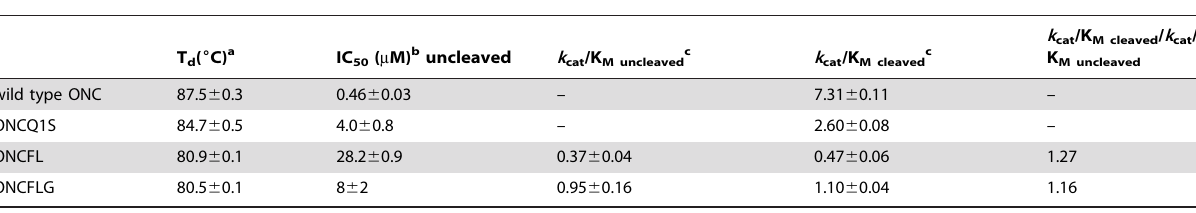
Table 1. Analysis of the stability and functionality of ONC